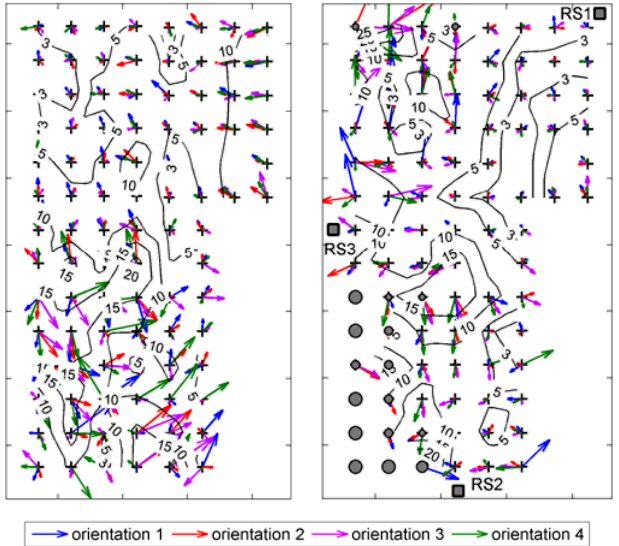
Figure 5. Deviations of the position estimates using the logarithmic one-slope (left) and the differential approach (right) in dependence of the user’s orientations for static